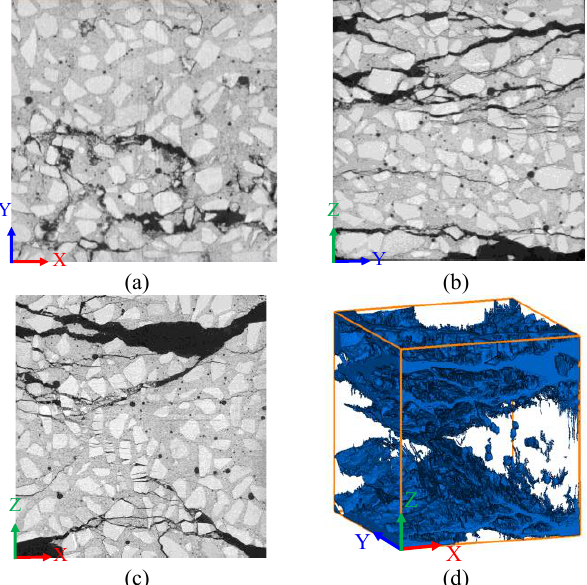
Fig. 6. CT images of concrete failure under dynamic loading and biaxial confinements: (a) XY slice, (b) YZ slice, (c) XZ slice and (d) 3D fracture volume